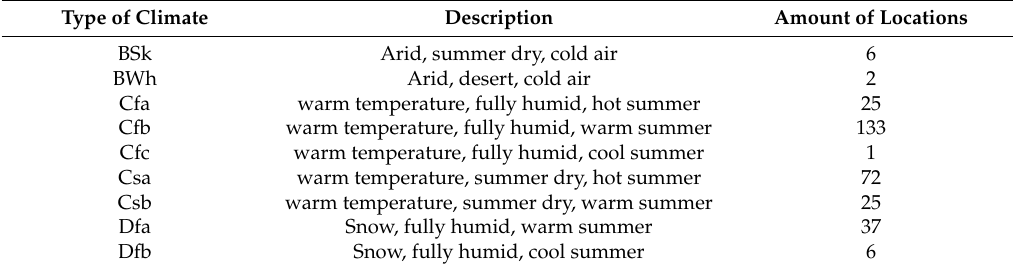
Table 1. Number of locations included in the database in relation to the Köppen-Geiger climate classification. Type of Climate